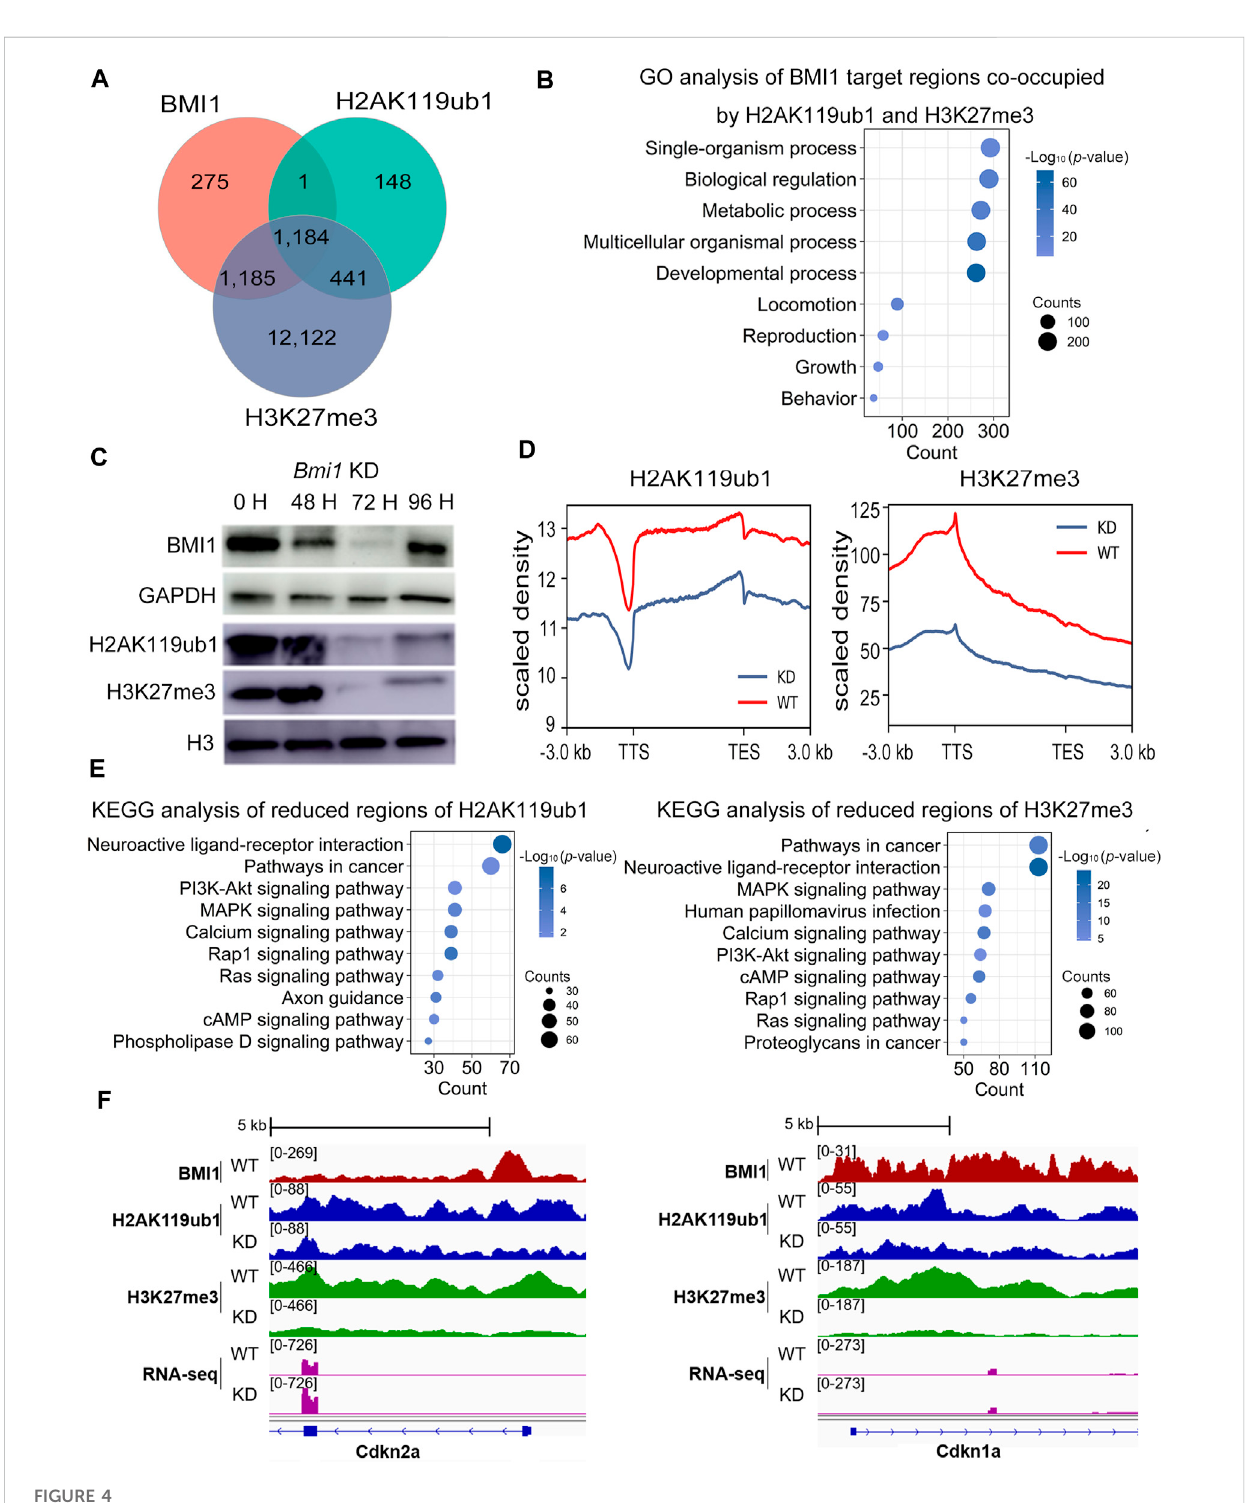
FIGURE 4 Bmi1 knockdown impairs repressive chromatin and disturbs undifferentiated spermatogonia state. (A) Venn diagram shows the overlap among target regions of BMI1, H2AK119ub1 and H3K27me3. (B) GO analysis of biological functions of BMI1 target regions co-occupied by H2AK119ub1 and H3K27me3. (C) Western blotting analysis of H2AK119ub1 and H3K27me3 levels during Bmi1 knockdown. (D) Density pro fi le of H2AK119ub1 and H3K27me3signaltracks,after Bmi1 knockdown. (E) KEGGanalysisofreducedregionsofH3K27me3andH2AK119ub1after Bmi1 knockdown. (F) IGV shows the binding pro fi les of BMI1, H2AK119ub1 and H3K27me3 ChIP-seq results together with RNA-seq data from WT and Bmi1 KD cells at genes of Cdkn2a and